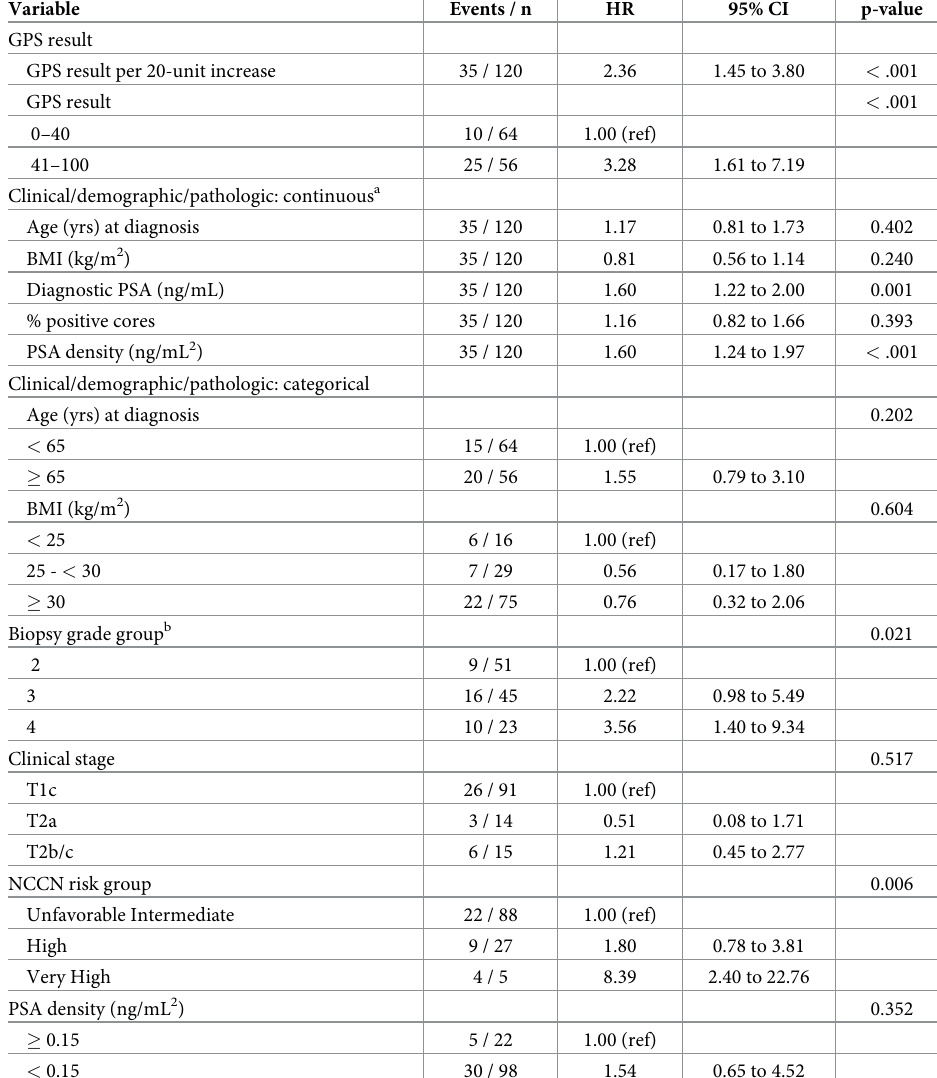
Table 2. Hazard ratios in univariable models (n = 120).